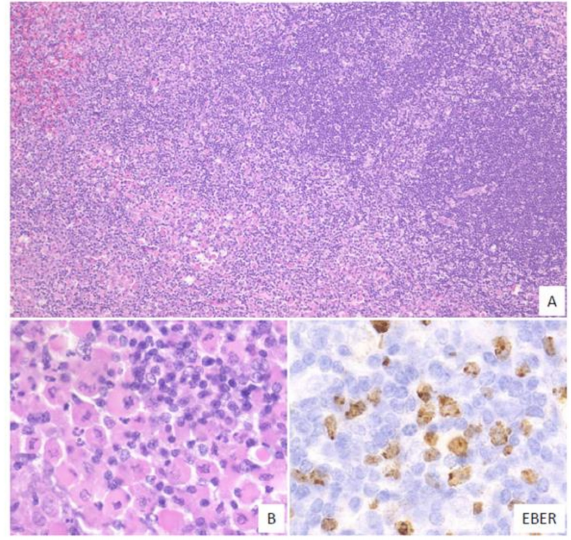
Figure 5. Pathologic findings for mucosa-associated lymphoid tissue (MALT) lymphoma-like EBVMCU. A lingual EBVMCU in a patient undergoing methotrexate treatment. ( A ) The atypical lymphoid cells show centrocytic-like features with plasmacytic differentiation and are proliferating in the expanded interfollicular zone (magnification, × 100). ( B ) Atypical plasmacytic cells with Russell bodies are seen (magnification, × 400). The atypical lymphoid cells are positive for EBER (magnification, ×